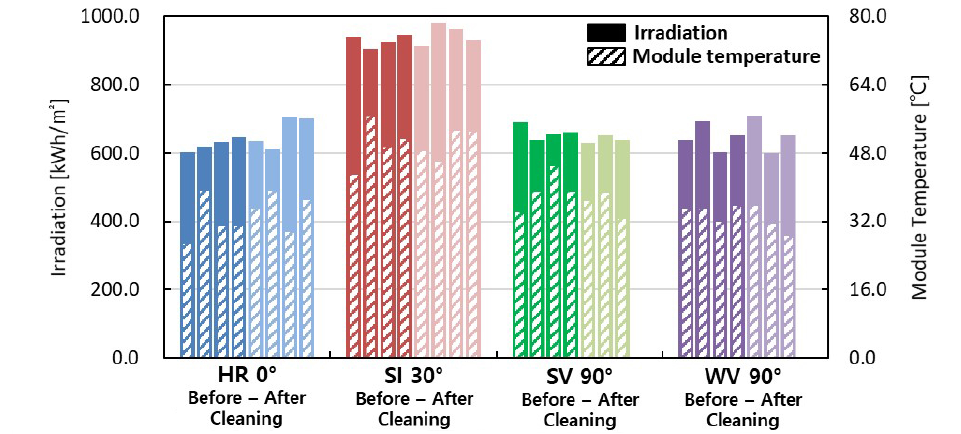
Figure 9. Irradiation and module temperature of each arrays during the analysis period (1 h).